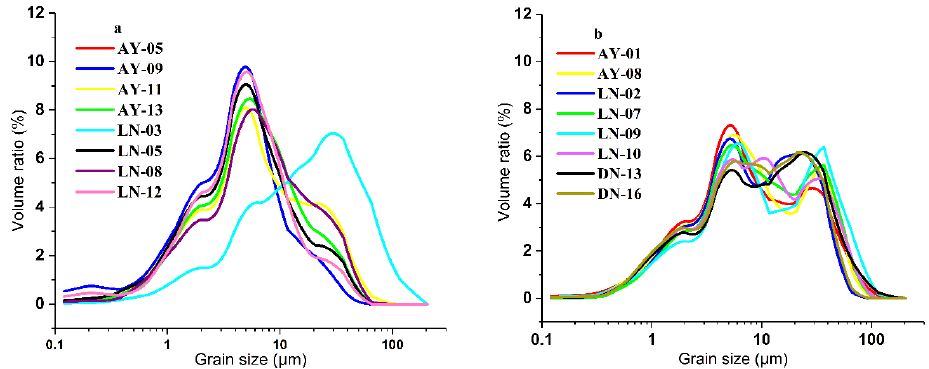
Figure 2. Grain size distribution of 27 regional samples: ( a ) shows unimodal patterns; and ( b ) shows bimodal